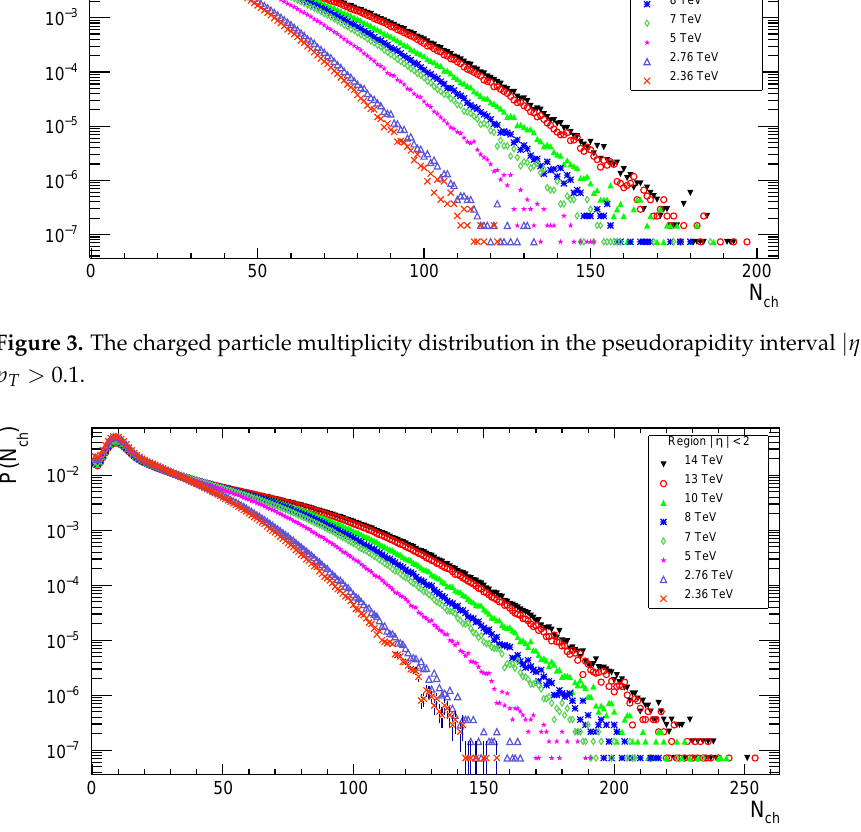
Figure 4. The charged particle multiplicity distribution in the pseudorapidity interval | η | < 2.0, with p T > 0.1.